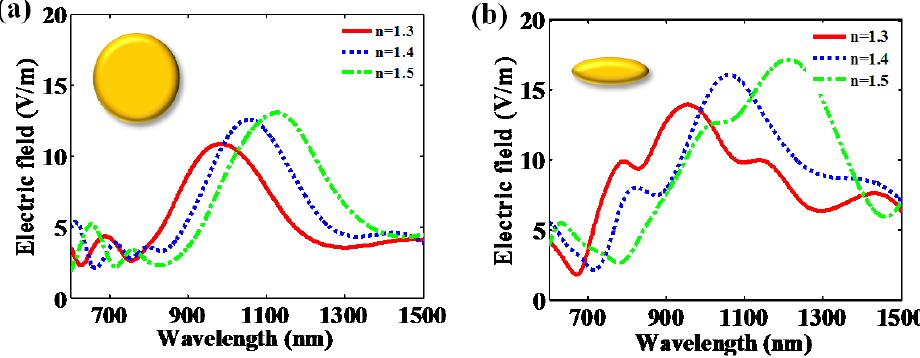
Figure 4. Optical spectra in response to the variation of surrounding refractive indexes from 1.3 to 1.5 at the nanodisk structure with respect to (a) aspect ratio 1:1 and (b) aspect ratio 5:1. Incident electric field is 1